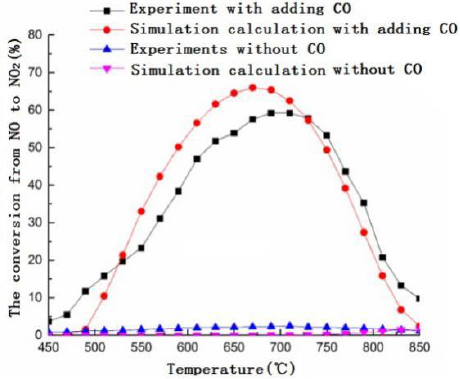
Figure 6. Effect of temperature and CO on the conversion.